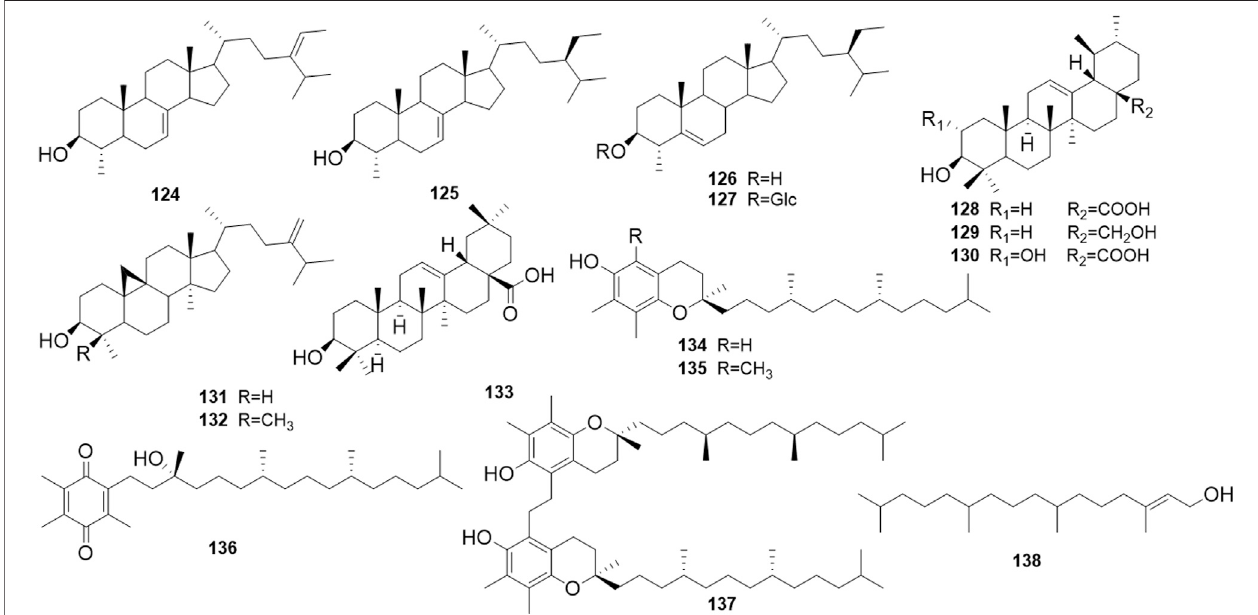
FIGURE 6 | Structures of the steroids and terpenes (124 – 138) form P. mume .